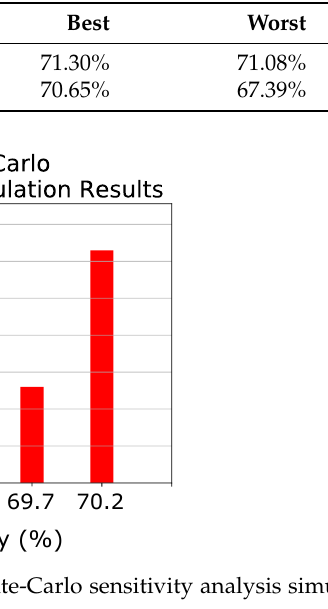
Figure 8. The alarms triggered by the classifier for four patients in a 24-h period. The ideal behavior is the raising of at least one alarm in each pre-ictal period, without raising alarms during the inter-ictal ones. The ictal and post-ictal regions are irrelevant for the classifier. Table 4. Specificity (over 20 iterations).